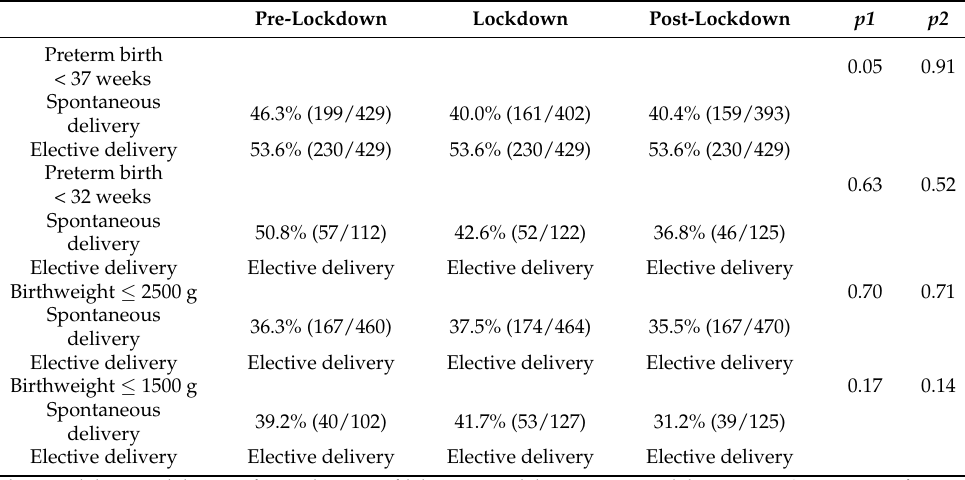
Table 4. Elective versus spontaneous deliveries within each group for preterm birth and low birth- weight